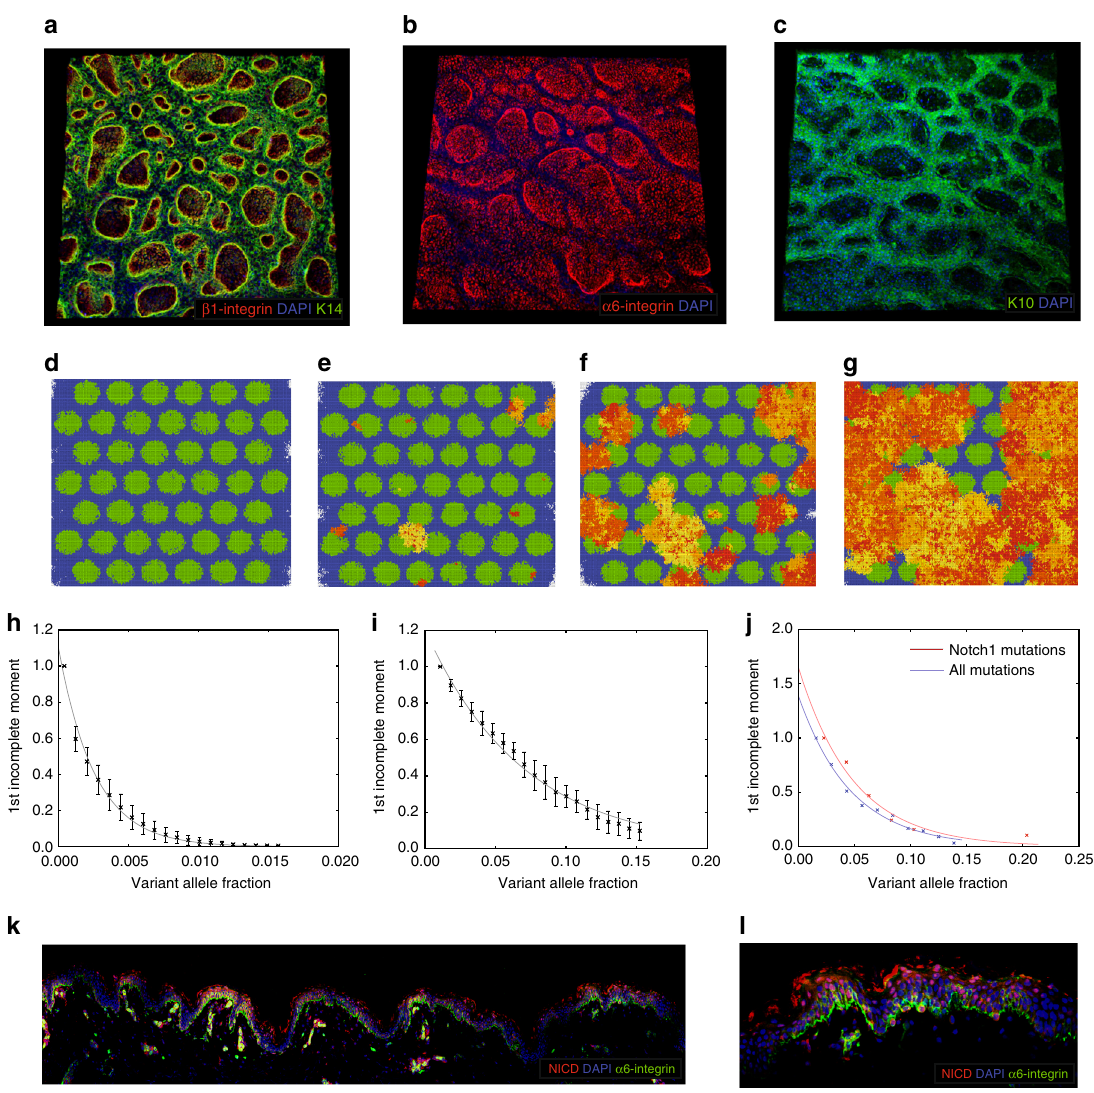
Fig. 4 Modelling clonal expansion of mutations in the human epidermis. a Whole-mount imaging of basal layer of human epidermis with labelling of β 1-integrin (red, stem cell marker), DAPI (blue, nuclear marker), Keratin 14 (green, basal layer marker). b Whole-mount imaging of basal layer of human epidermis with labelling of α 6-integrin (red, stem cell marker) and DAPI (blue, nuclear marker). c Whole-mount labelling of basal layer of human epidermis with labelling of keratin 10 (green, differentiation marker) and DAPI (blue, nuclear marker). d – g Simulation of clonal evolution of 99,225 stem cells (green), transit amplifying cells (TA; blue) and empty spaces (white) on a 315 × 315 hexagonal lattice after 140 days ( f ) 620 days ( g ) 1100 days ( h ) and 1600 days ( i ). Stem cell cluster radius is 20 cells. Neutral mutation rate for all cells is 10 – 3. Notch mutations (yellow-red) arise stochastically with rate 10 – 6 cell-1 day-1 and prevent differentiation of stem cells to TA cells. Unique clones within an expanding Notch-mutant clone are indicated by an arbitrary colour within the yellow-red spectrum. h Clone size distribution resulting from simulation of stem cells and TA cells in the basal layer of the epidermis with neutral mutations only (10 years, 315 × 315 lattice,10 replications with clones detectable by sequencing ( > 0.007 VAF) mean ± S.D.) i Clone size distribution resulting from simulation of stem cells and TA cells in the basal layer of the epidermis in the presence of Notch mutations. Note that scale is 10-fold greater than ( j ). (10 years, 315 × 315 lattice,10 replications with clones detectable by sequencing ( > 0.007 VAF) mean ± S.D.). j Observed clone size distribution for all mutants (blue) and Notch1 mutants (red) detectable in the human epidermis. k , l Notch1 activity in the human epidermis. Active Notch1 signalling is indicated by positive staining for the Notch intracellular domain (NICD, red). α 6-integrin (green, stem cell marker) and DAPI (blue, nuclear marker) are also integrin (clone P5D2; Millipore MAB1959; 1:500), FITC-conjugated anti- α 6- Human epidermal whole-mounts were prepared and labelled using a integrin (CD49f) antibody (clone GOH3; 1:200), chicken anti-Krt14 (Covance, procedure that was modi fi ed from previous reports 7, 43 . Breast or abdomen SIG2376, 1:500), rabbit anti-K10 (Covance, PRB-159P, 1:500)] in PB buffer skin samples were obtained as surgical waste with appropriate ethical approval. overnight at 4°C in a 24-well tissue culture plate. Samples were washed and Small pieces (2 cm 2 ) of whole skin were treated with Dispase (Corning) incubated with corresponding secondary antibodies for 2h in room temperature overnight on ice at 4°C. The epidermis was separated as an intact sheet from and washed before mounting on a slide with ProLong anti-fade mounting medium the dermis and immediately fi xed in 4% paraformaldehyde for 1h. Epidermal (Thermo Fisher) with DAPI (4 ′ ,6-diamidino-2-phenylindole) to reveal nuclei. sheets were then washed and stored in PBS containing 0.2% sodium azide at A Nikon A1 confocal microscope was used for image acquisition. NIS 4°C until staining. Sheets were permeabilised and blocked using PB buffer Elements (Nikon Instruments Inc.) software was used for 3D maximal (0.5% skimmed milk powder, 0.25% fi sh skin gelatin, 0.5% Triton-X 100, projection (1024× 1024 dpi), volume rendering and deconvolution on z -stacked HEPES-buffered saline) for 30 min at 37 °C in a shaking incubator at 100r.p.m. whole-mount images. Epidermal sheets were then stained with speci fi c primary antibodies [anti- β 1